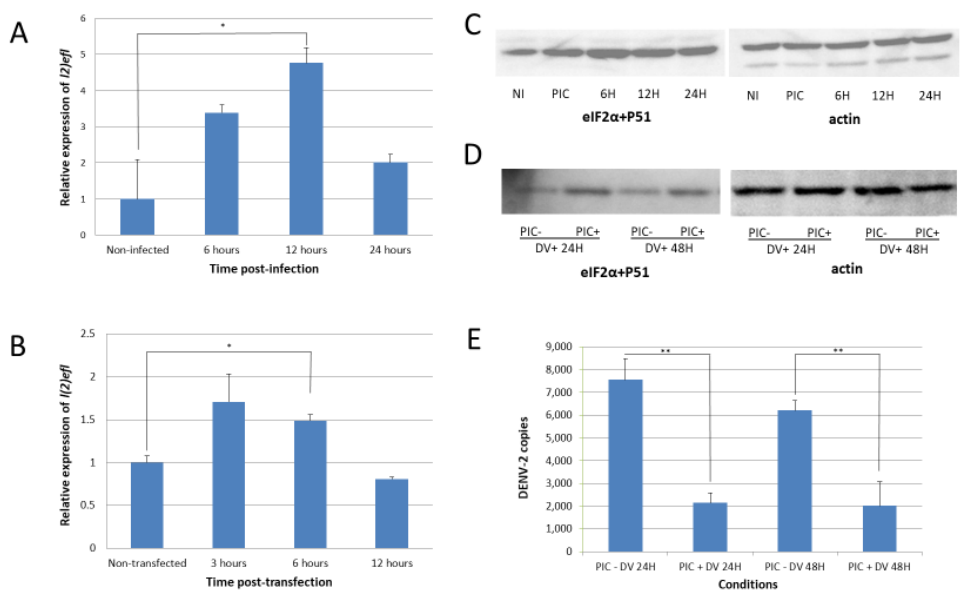
Figure 2. Dengue-virus infection increases the l(2)efl expression and phosphorylates eIF2 α in CCL-125 cells. ( A ) When infected with dengue virus (DENV), l(2)efl was upregulated as high as ~5-fold, with a peak at 12 h post infection (hpi). ( B ) The poly(I:C) synthetic dsRNA also upregulated the l(2)efl expression as high as ~1.6-fold, with a peak at 3 hpi. ( C ) DENV infection caused the phosphorylation of eukaryotic translation initiation factor 2, subunit 1 alpha (eIF2 α ). ( D ) Transfection with poly(I:C) and subsequent infection DENV resulted in higher phosphorylation levels up to 48 hpi. ( E ) Induction of l(2)efl by poly(I:C) and the phosphorylation of eIF2 α reduced the DENV type 2 replication at 24 and 48 hpi. All the experiments were performed using three biological replicates (except for Figure D, which had two biological replicates). NI: noninfected; PIC: poly(I:C); DV: dengue virus. * p < 0.05, ** p < 0.01.